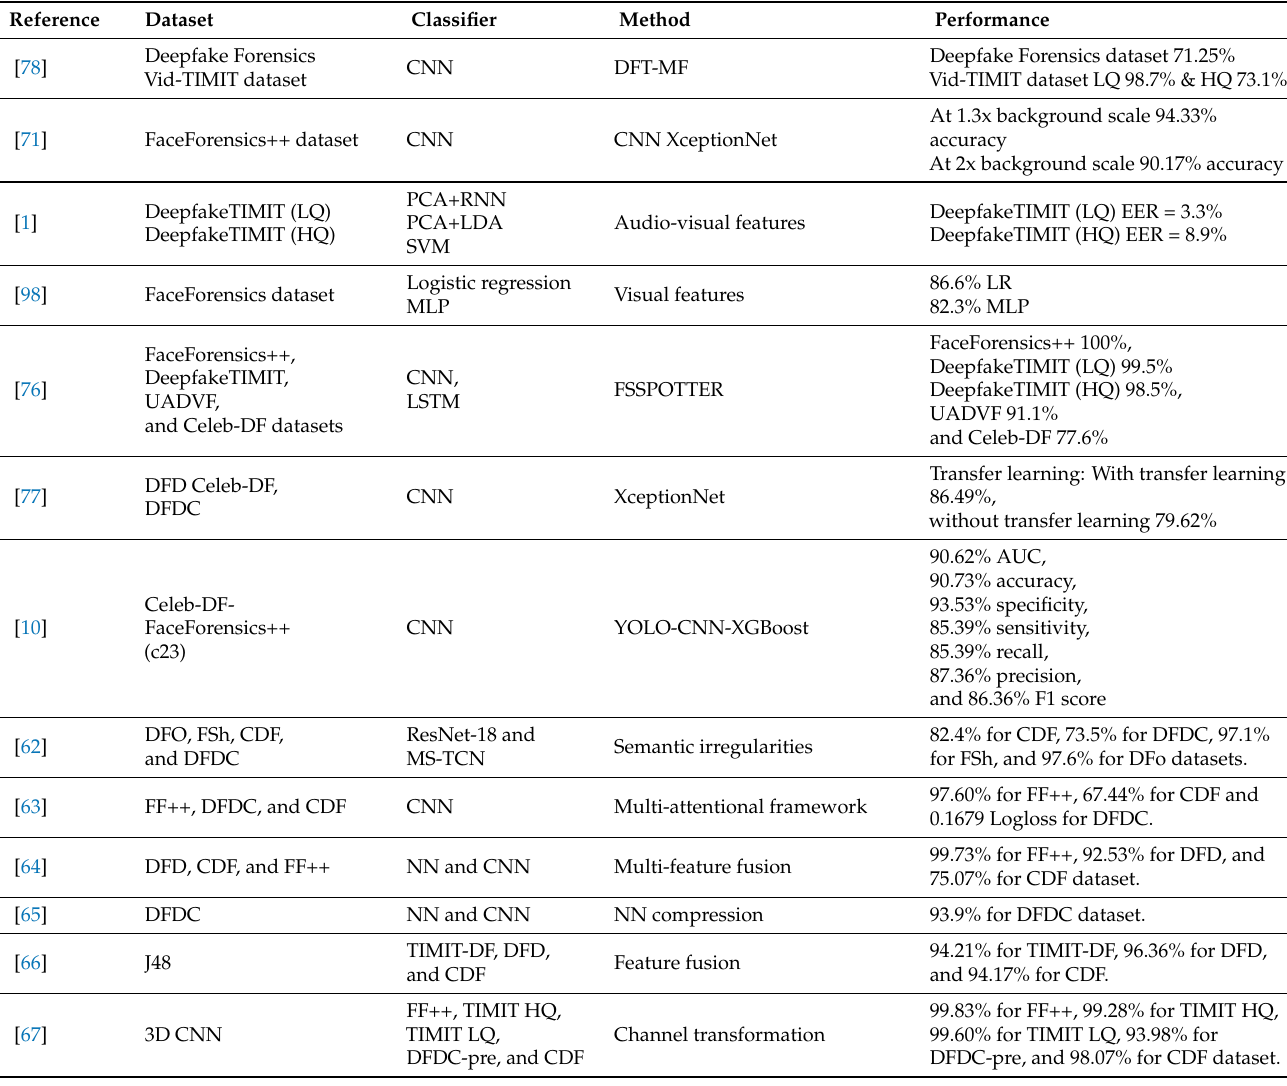
Table 5. Comparison of benchmark